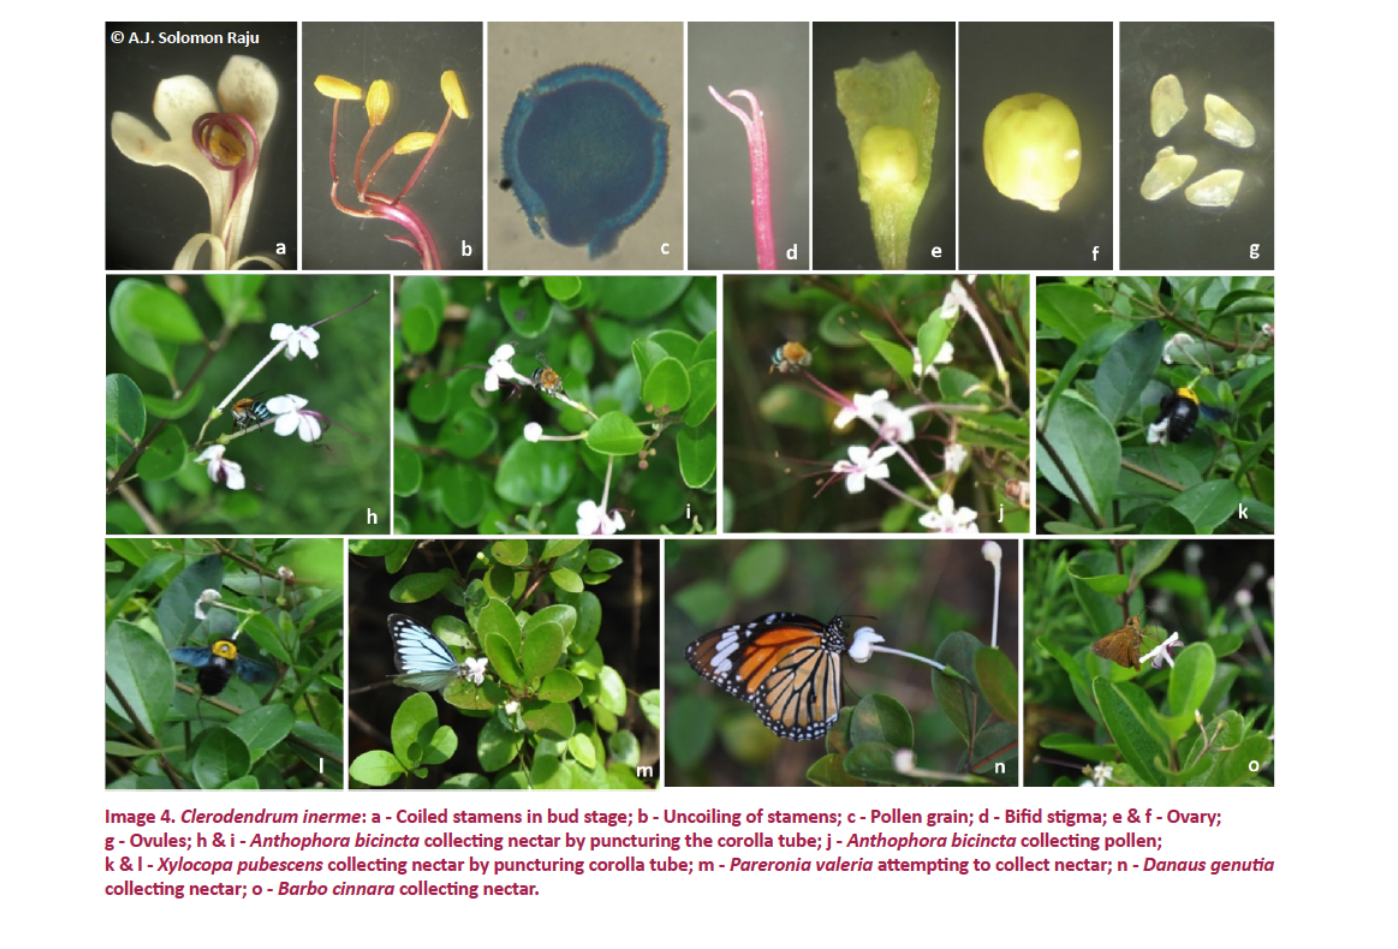
Image 4. Cflerodendrum inerme: a - Coifled sftamens in bud sftage; b - Uncoifling off sftamens; c - Poflflen grain; d - Biid sigma; e & ff - Ovary; g - Ovufles; h & i - Anfthophora bicincfta coflflecing necftar by puncfturing fthe coroflfla ftube; j - Anfthophora bicincfta coflflecing poflflen; k & fl - Xyflocopa pubescens coflflecing necftar by puncfturing coroflfla ftube; m - Pareronia vafleria aftemping fto coflflecft necftar; n - Danaus genuia coflflecing necftar; o - Barbo cinnara coflflecing necftar.